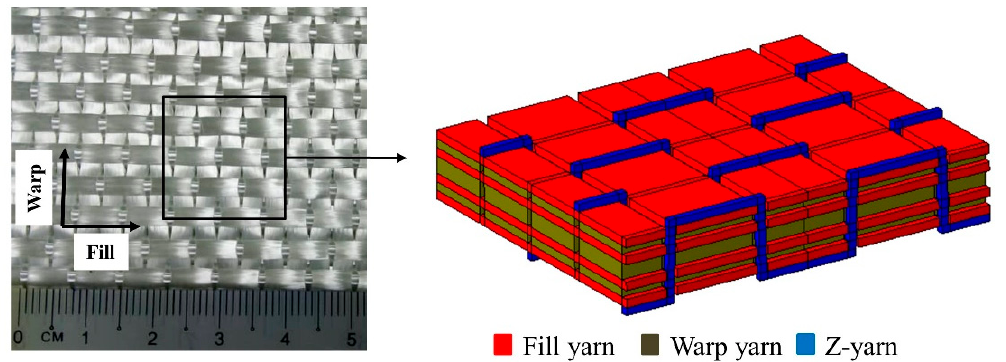
Figure 3. 3D orthogonal fiber-reinforced composites.